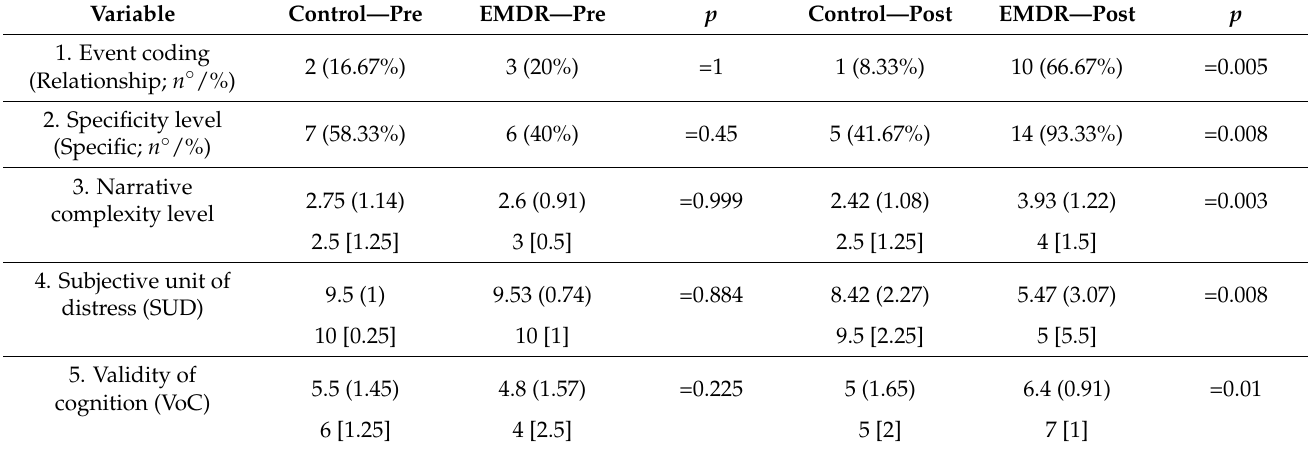
Table 1. Group comparisons among the study measures between EMDR ( n = 15) and control (12) samples assessed pre-intervention and